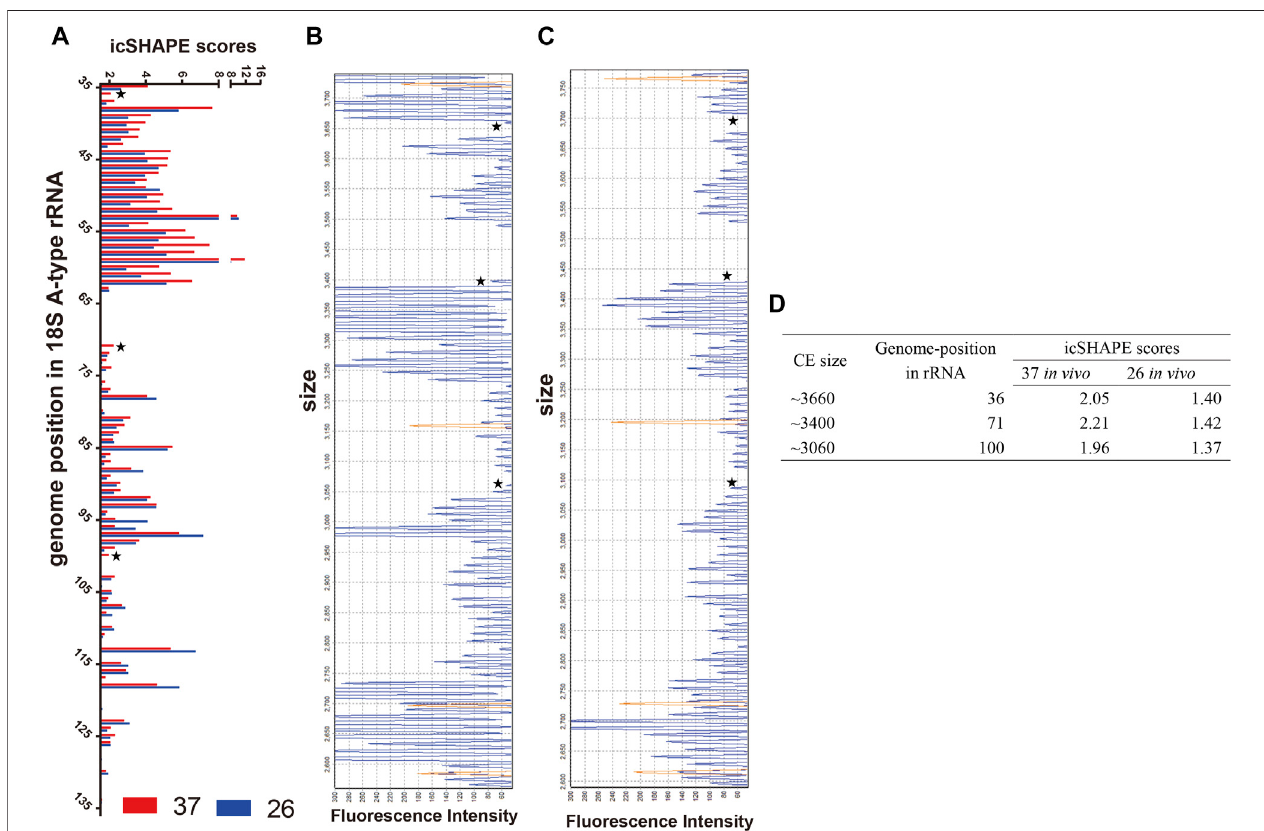
FIGURE 4 | icSHAPE scores for the 5 ′ -end of the 18S A-type ribosome RNA from the 37 ° C control group and the 26 ° C treatment group in the trophozoite developmental stage combined with CE gel results. (A) icSHAPE scores from 37 ° C to 26 ° C groups for nucleotides 35 – 135 are shown on the left. Those two gels from 18S A-type rRNA of the 37 ° C control group (B) and the 26 ° C treatment group (C) with NAI-N 3 modi fi cation were read out by CE experiment. For those two panels of capillary electrophoresis, the starting RNA material was the same as the total in vivo NAI-N 3 -modi fi ed RNA. The orange traces in (B, C) is GeneScan 500 LIZ Size Standard for capillary electrophoresis gel (from top to bottom: 250, 200, 160, and 150 bp), and the stars represent the three genome positions in 18S A-type rRNA, which are signi fi cantly different between the 37 ° C control group and the 26 ° C treatment group. (D) The icSHAPE scores, CE size, and the position in the rRNA genome from three different base-pair